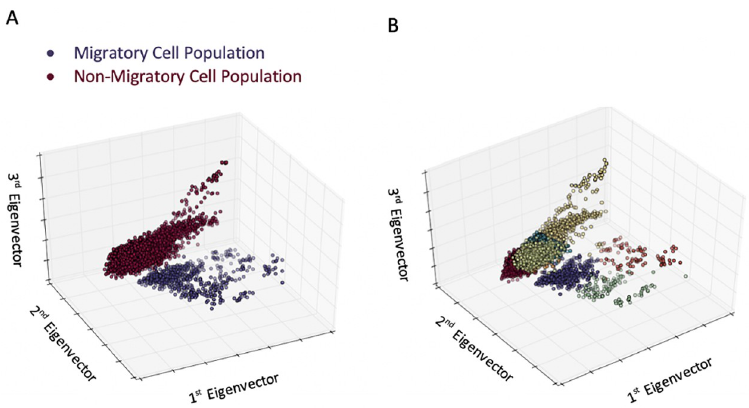
Fig 4. Unsupervised analysis of highly motile cells separated from the bulk population chamber via a Boyden chamber . A: Projections of migratory (blue) and non-migratory (red) MDA-MB-231 cells. The migratory and non- migratory fractions segregate into distinct clusters of cells, with many individual or small clusters of cells expanding into the periphery, away from the main clusters, indicating the presence of morphological sub-phenotypes. B: Using the k-means clustering algorithm with the strict criterion that clusters must have a homogeneity greater than 0.95, we find seven distinct clusters. In the absence of genetic profiling, we cannot confirm the biological role of these clusters, but have demonstrated that morphology alone is enough to distinguish, cluster, and analyze cell sub-phenotypes.